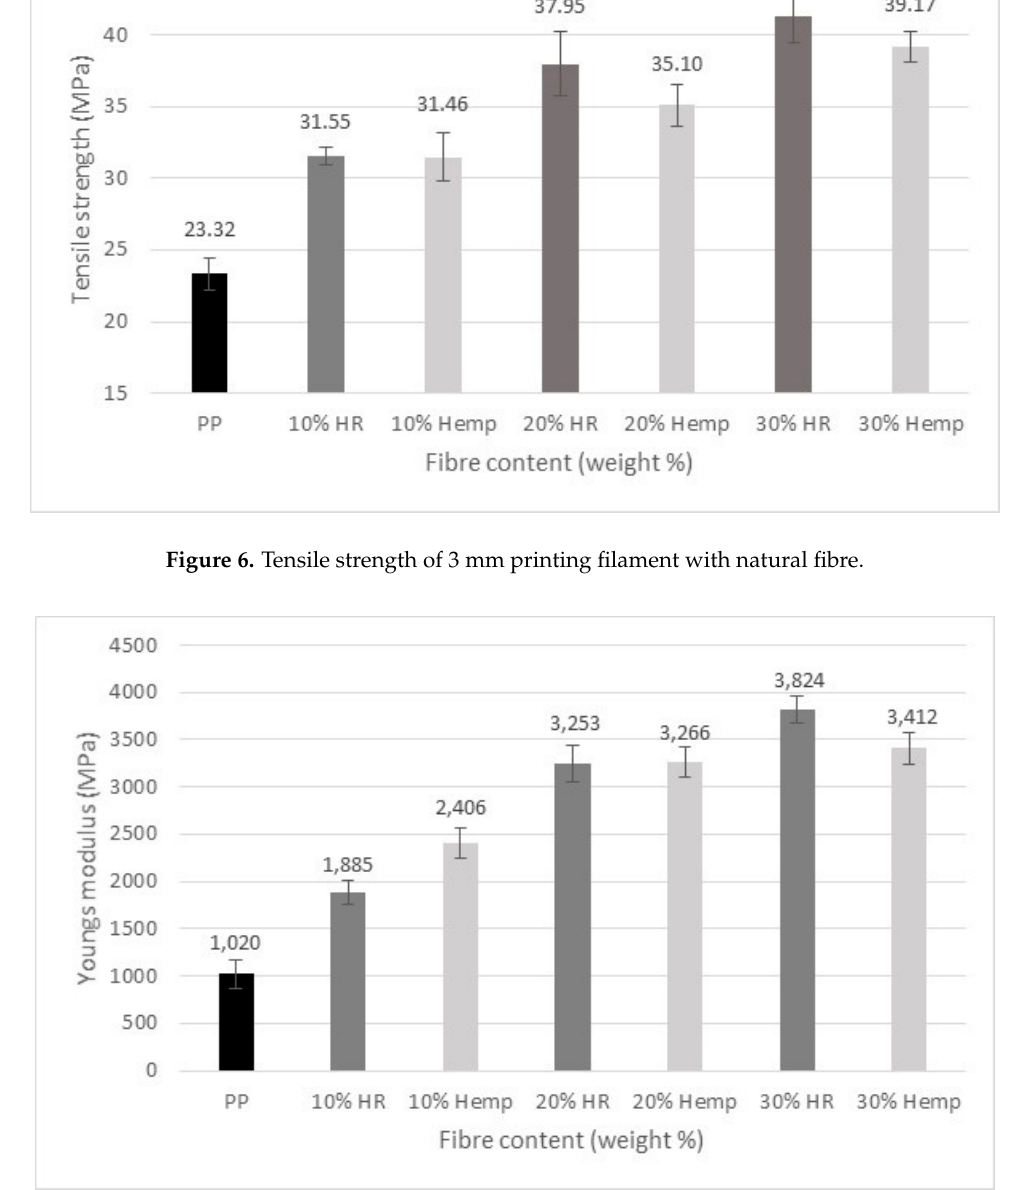
Figure 7. Young’s modulus of 3 mm printing filament with natural fibre.